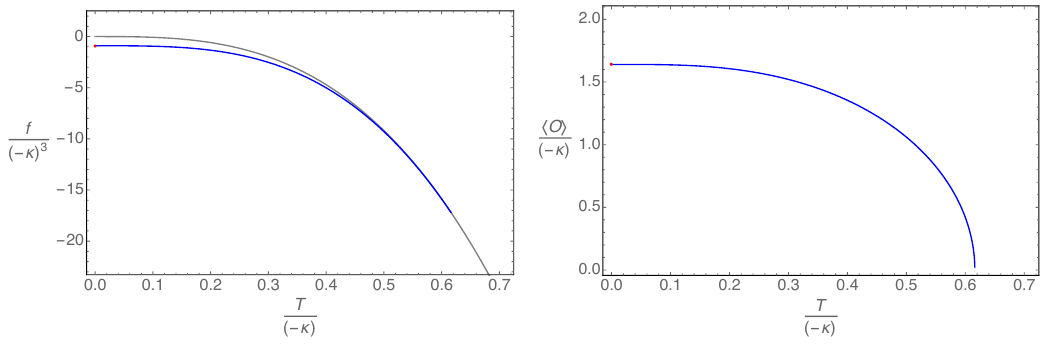
Figure 2 . Left: the free energy across second order phase transition. The grey and blue lines are the free energy densities of Schwarzschild black hole and hairy black hole respectively. The red dot is the free energy of the hairy black hole at zero temperature. Right: the order parameter h O i / ( − κ ) as a function of T/ ( − κ )